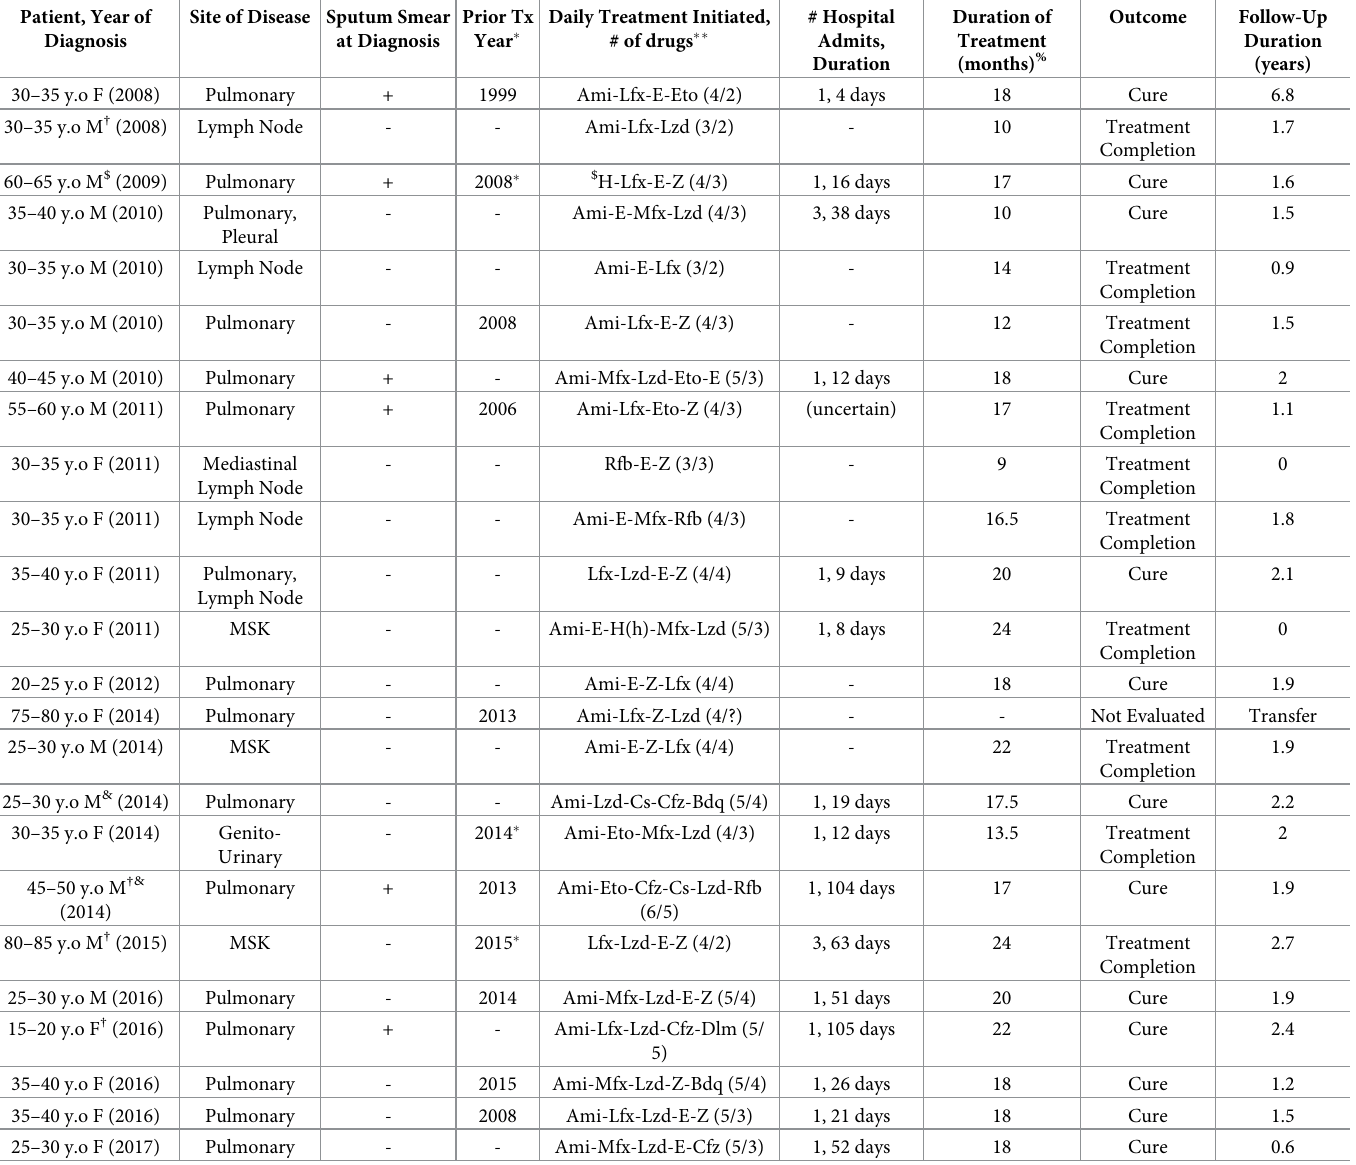
Table 3. Patient clinical course and outcomes (n =